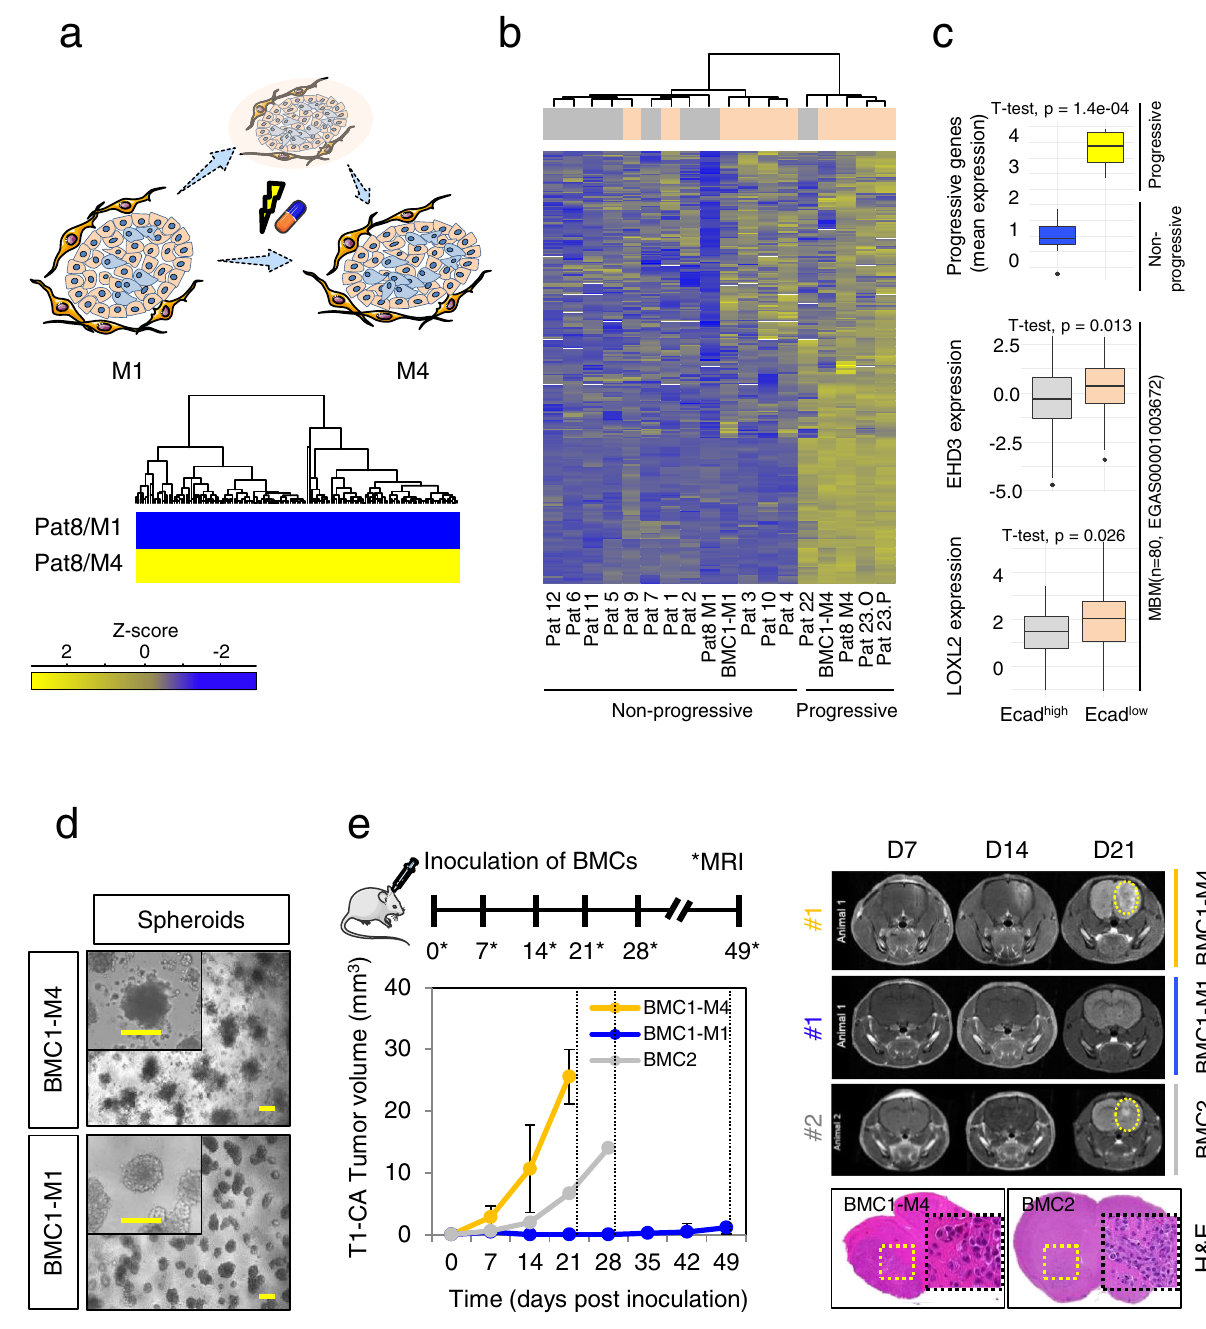
Fig. 6 | A gene signature de fi nes progressive stages of MBM. a Pat 8/M1 and M4 tumors represent genetically concordant subclones that emerged sequentially or independent. M1 only received XRT/ICi but not BRAFi/MEKi therapy; M4 emerged underBRAFi/MEKiandprogressedunderICitherapy,henceM1andM4aretermed non/less-progressive and resistant/progressive tumors. Lower panel: The com- parativepro fi lingandanalysisofbothuncoveredasignature1063DEGsandacore signature of 389 genes. b Clustering of MBM regarding the expression of core genes subdivides progressive and non-progressive tumors. c First panel: Box plot shows mean expression values of signature genes of progressive and non- progressive tumors. Center and bottom panels: Box plots showing expression of progressive genes EHD3 and LOXL2 in an independent set of Ecad high and Ecad low MBM ( n =80, study EGAS00001003672). d Embedding of indicated BMCs in matrigel established three-dimensional growing spheroids and demonstrated dif- ferences of invasive phenotypes. Bars indicate 50 µ m. e Upper scheme: